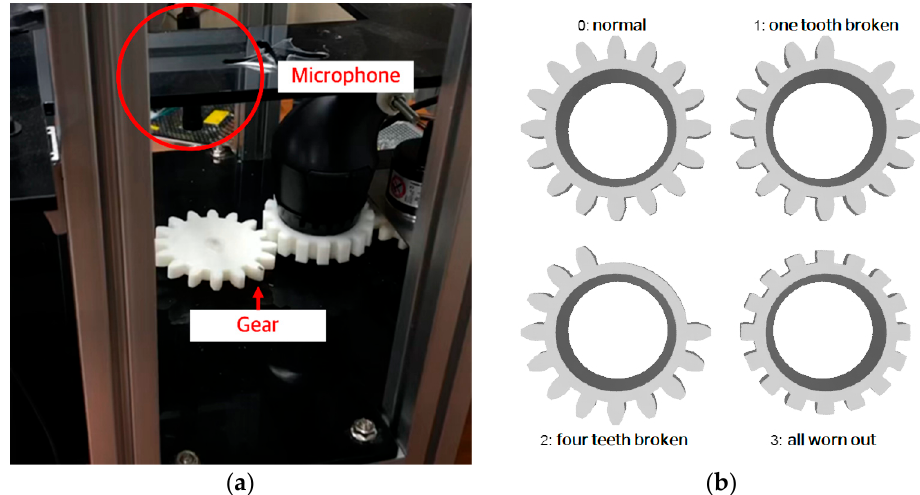
Figure 1. Setting for a gear’s defect diagnosis: ( a ) hardware for defect diagnosis; ( b ) type of normal gear and defect gears.